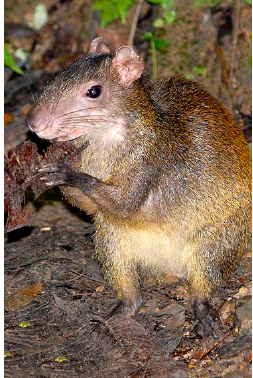
Figure 20. Agouti paca populations have increased in the project area.